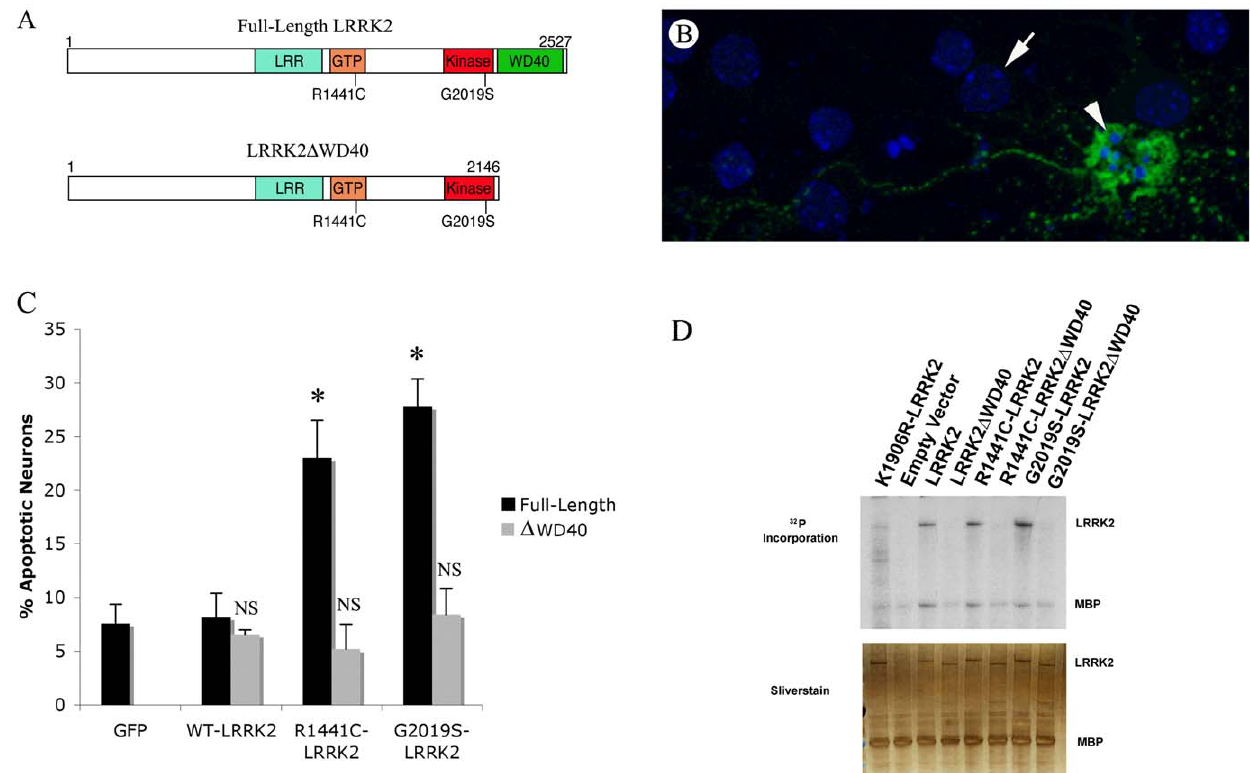
Figure 2. The WD40 domain is critical for LRRK2 neurotoxicity and autophosphorylation. (A) Schematic of LRRK2 and D WD40-LRRK2 showing major domains. The WD40 domain was removed by terminating LRRK2 at amino acid 2146. (B) A LRRK2-transfected apoptotic neuron. The arrow indicates a non-apoptotic nucleus, and the arrowhead indicates an apoptotic cell co-transfected with GFP and RC-LRRK2. (C) Removal of the WD40 domain abolishes the neurotoxicity of PD-mutant forms of LRRK2. Wild-type LRRK2 (WT), R1441C LRRK2 (RC), and G2019S LRRK2 (GS) with and without the WD40 domain ( D WD40) were assessed for neurotoxicity. Murine cortical neurons were co-transfected with LRRK2 constructs and GFP, and the percentage of apoptotic nuclei were assessed 48 hours post-transfection. Data represent the mean 6 seven individual experiments. Data was assessed using ANOVA followed by Duncan’s Multiple Range analysis p , 0.05. (D) Removal of the WD40 domain has a differential effect on LRRK2 autophosphorylation and trans-phosphorylation. The different forms of LRRK2 were immunoprecipitated from 293T cells and assessed for their ability to autophosphorylate and to trans-phosphorylate MBP. Top panel is an autoradiogram and bottom panel is silver-stained gel demonstrating the presence of the different forms of LRRK2 and MBP in similar amounts between different